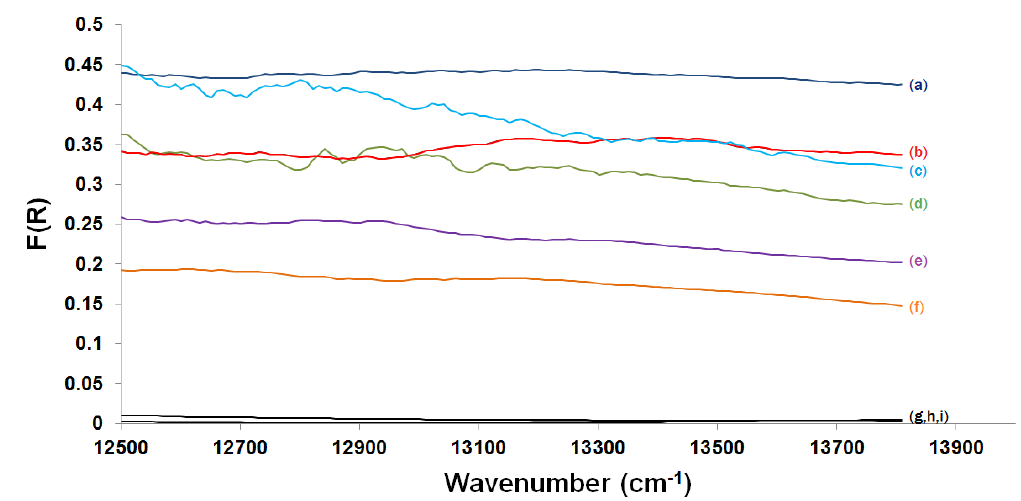
Figure 9. Kubelka-Munk scans for: ( a ) 0.5La catalyst post TPR 1; ( b ) 0La catalyst post TPR 1; ( c ) 1La catalyst post TPR 1; ( d ) 0.5La catalyst post TPR 2; ( e ) 1La catalyst post TPR 2; ( f ) 0La catalyst post TPR 2; ( g ) 0La catalyst post TPO 1; ( h ) 0.5La catalyst post TPO 1; ( i ) 1La catalyst post TPO 1.